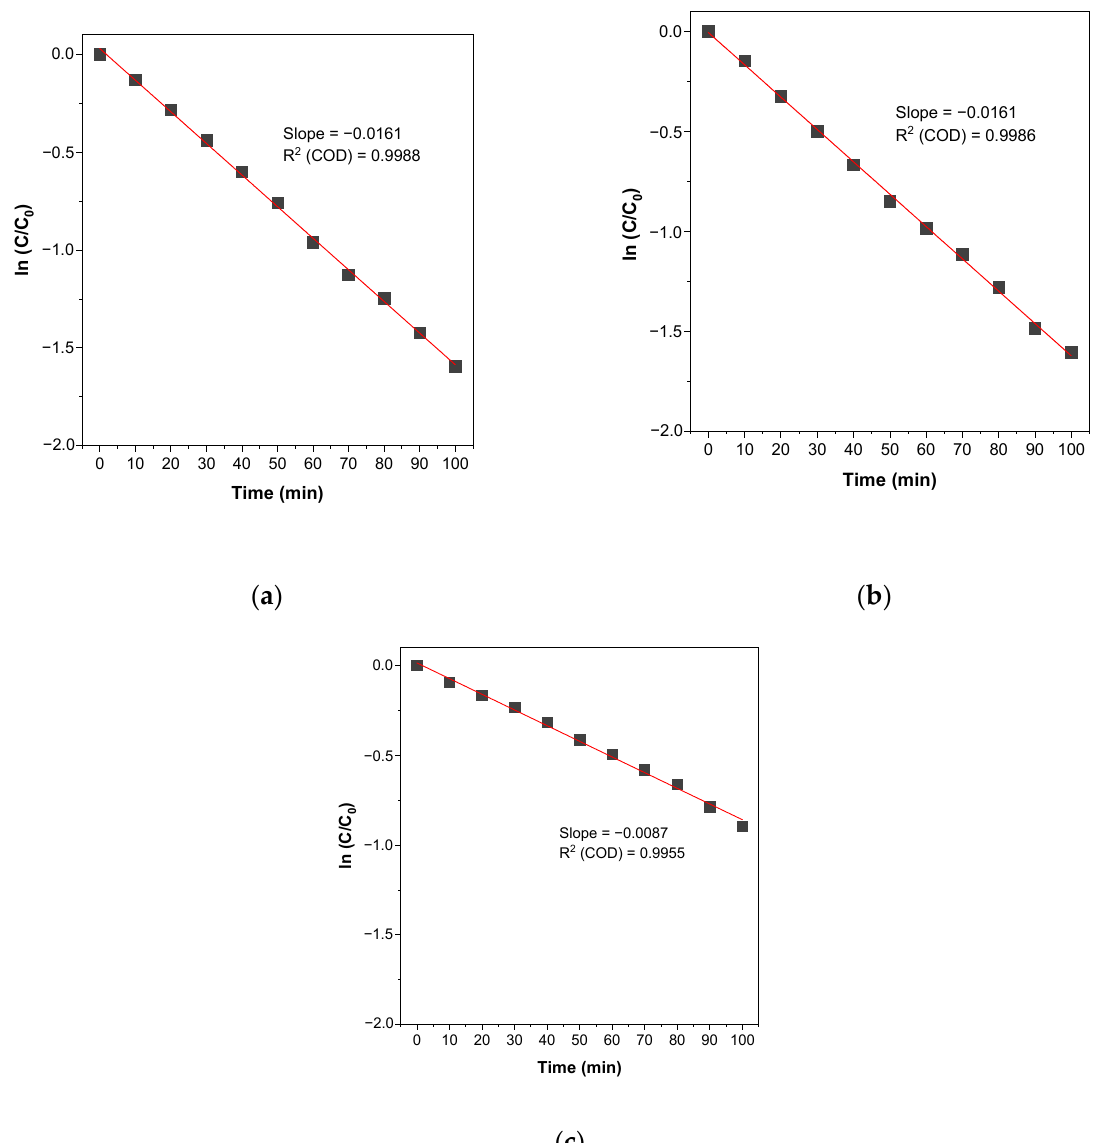
Figure 9. Kinetic study of the photocatalytic degradation of the azo dyes ( a ) MO, ( b ) AO7, ( c ) AY23 by the oxidation process. (Experimental conditions: initial dye concentration 0.042 mM; wavelength of UV irradiation: 254 nm; H 2 O 2 concentration: 4.8 M; photocatalyst concentration: 1.0 g/L.).